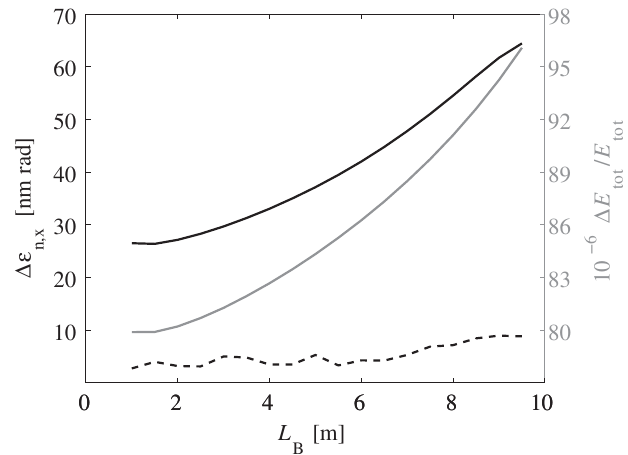
FIG. 3. Variation of projected (solid black) and slice (dashed black) CSR emittance growth with dipole length. As a compari- son, the relative energy loss of a 100 (cid:1) m long bunch traversing a single dipole of BC2 is also plotted (gray, right axis).